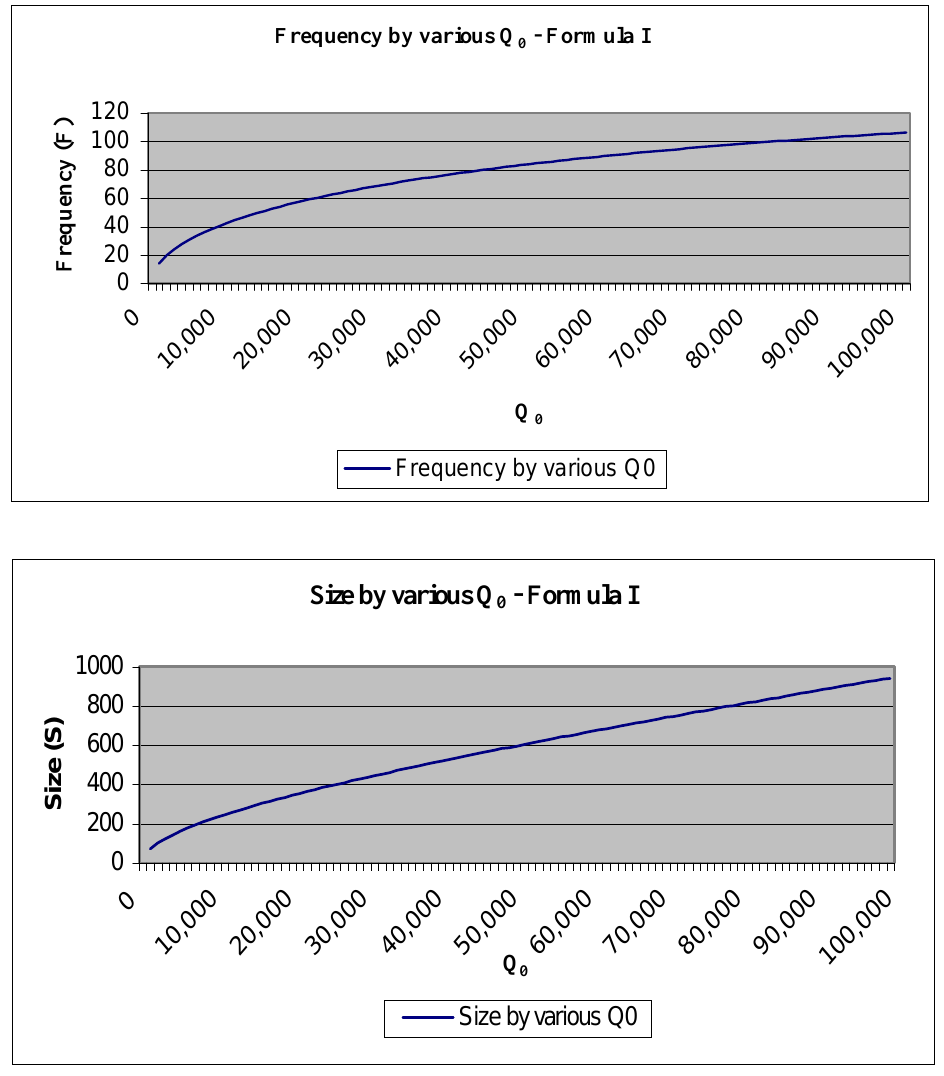
Figure 2. The relationship between travel demand, frequency and vehicle size (case